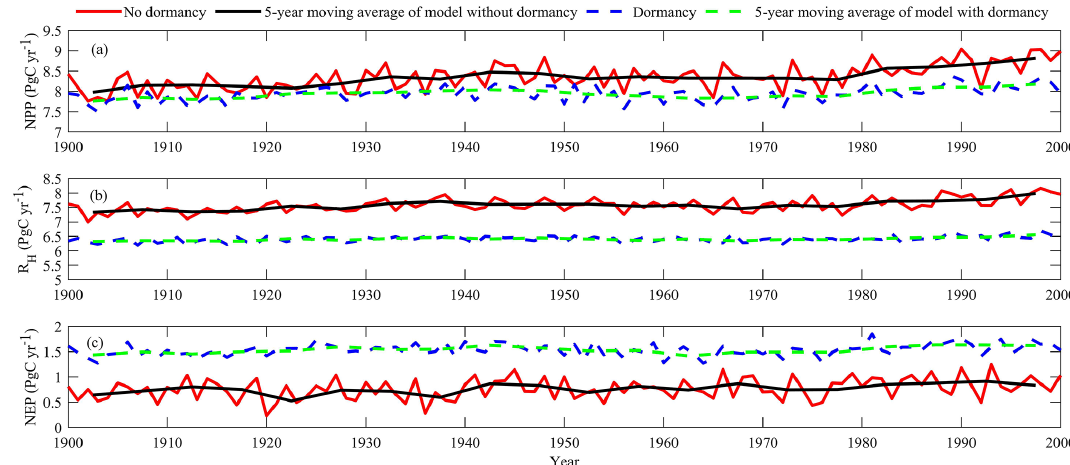
Figure 7. Simulated annual net primary production (NPP, a ), heterotrophic respiration ( R H , b ), and net ecosystem production (NEP, c ) during the 20th century by the dormancy model and